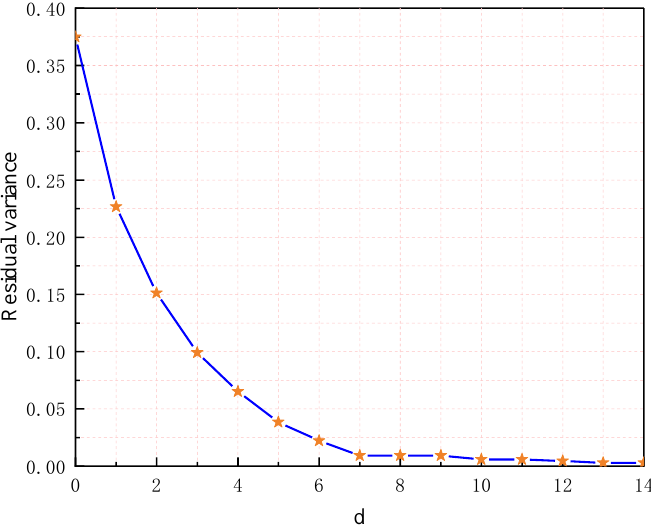
Figure 17. Comparison of the correctness of fault diagnosis models for different values of d .